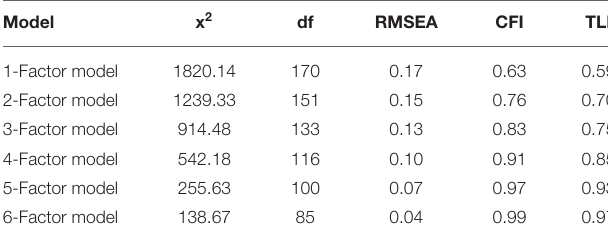
TABLE 1 | Exploratory factor analysis of K-WNSS (N = 339)